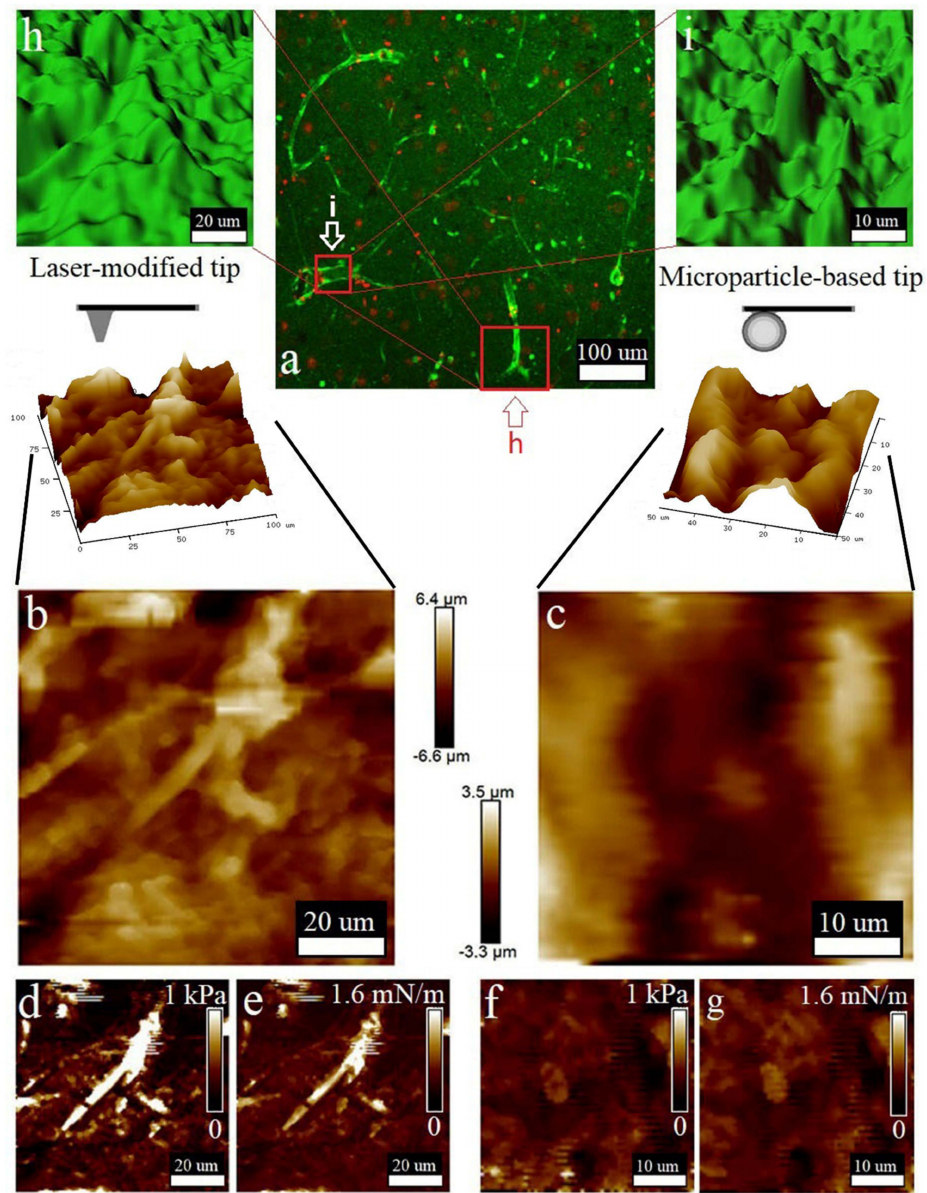
Figure 4. Surface properties of the rat brain slice studied by LSM ( a , h , i ) and AFM (laser-reshaped ScanAsyst Fluid High Resolution probe ( b , d , e ) and microbead-based cantilevers NP − 10 ( c , f , g ). ( a ) Large − scale LSM map showing the ratio of live (green glow) to dead cells (red glow). ( h , i ) Two areas show 3D reconstruction of the smaller map sections chosen for subsequent AFM studies with two types of cantilevers. Surface morphology of the chosen slice obtained using laser-reshaped ( b ) and microbead-based ( c ) cantilevers. Insets on both images provide 3D reconstructions of these areas. ( d , e ) Elasticity and stiffness AFM maps by laser − reshaped ScanAsyst Fluid High Resolution probe. ( f , g ) Elasticity and stiffness AFM maps by microbead − based cantilevers NP −